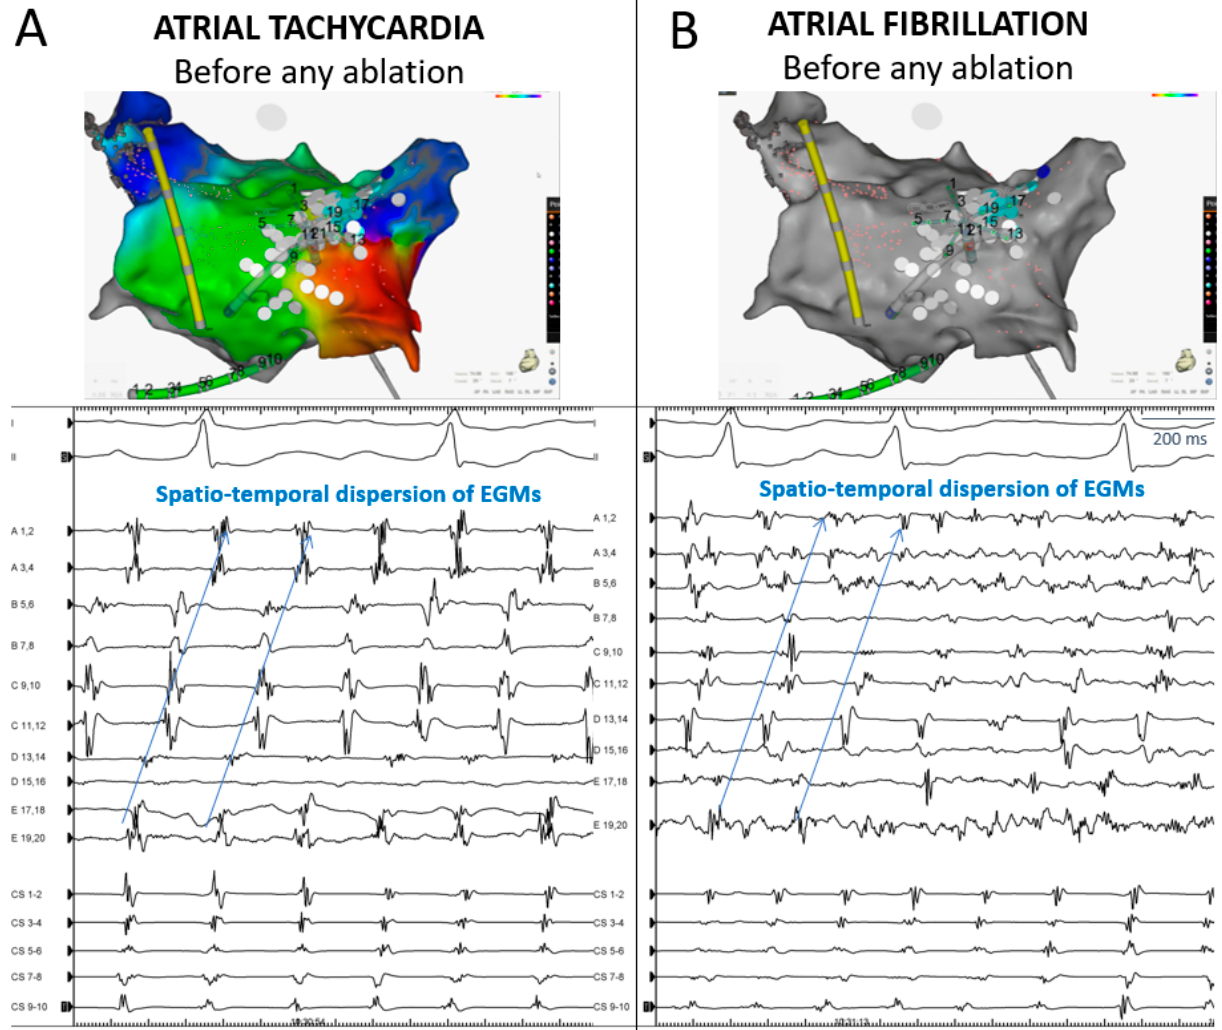
Figure 5. Posteroanterior 3D view of a left atrium alternatively in AT and AF prior to any ablation. The pattern of dispersion observed on a delineated posterior zone, during either AT (( A ) the activation map on the right shows a micro-reentry at the same location) or AF (( B ) the cluster of white tags indicates the area of dispersion beside the right pulmonary vein’s posterior antrum). AF, atrial fibrillation; AT, atrial tachycardia; AT-in, AT located inside; AT-out, AT located outside.